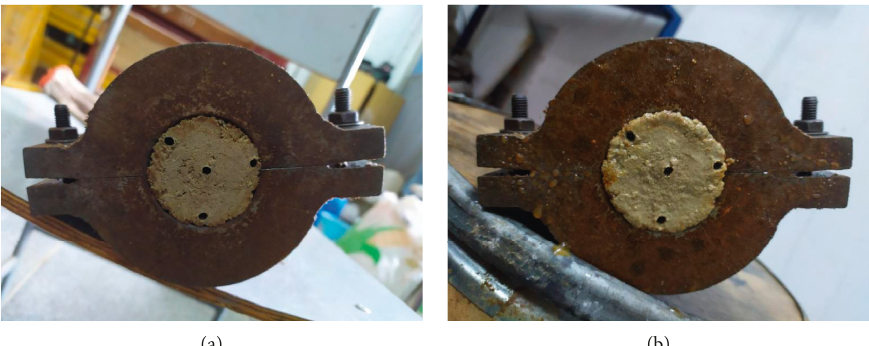
Figure 10: One comparison of the initial cracks and stable cracks: (a) initial cracks of experiment No. 12; (b) cracks steady of experiment No.